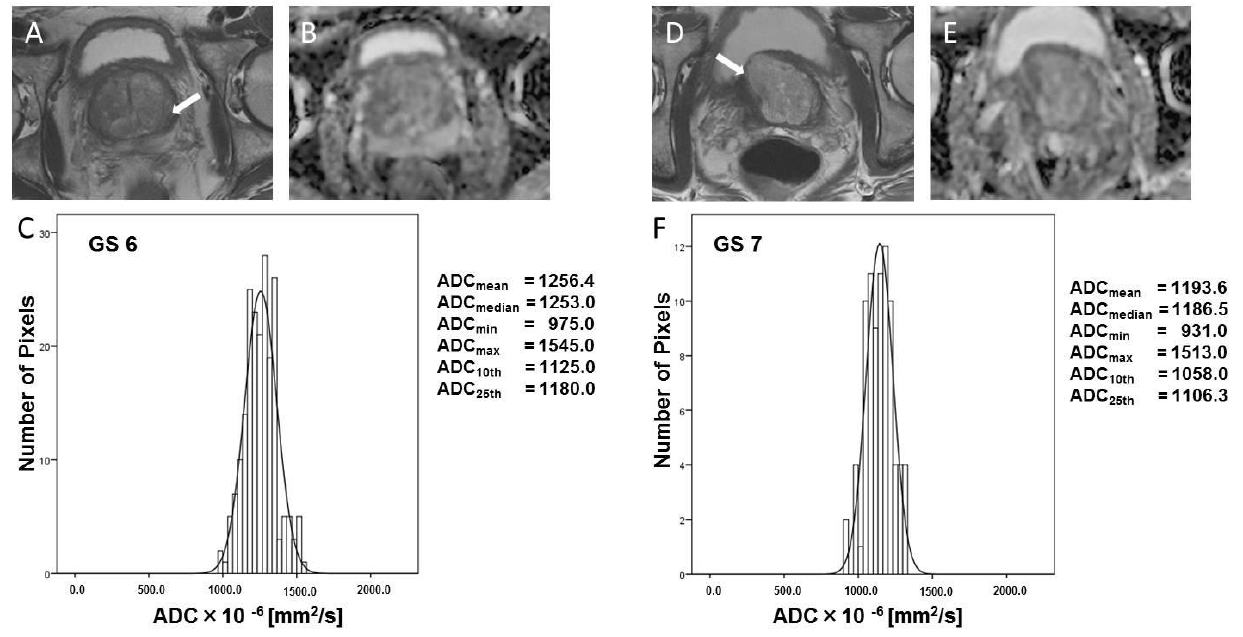
Figure 3. Typical histogram of tumor focus, and T 2 W and ADC images (GS 6 and GS 7). GS = Gleason score. Typical T 2 W images ( A , D ), ADC images ( B , E ), and ADC-derived histograms ( C , F ) for GS 6 and GS 7 prostate cancers. These T 2 W images of prostate cancer illustrate the low signal intensity. The ADC values of the GS 6 lesion reflect slightly restricted diffusion on the ADC map (( B ), ADC mean = 1256.4 × 10 −6 mm 2 /s). The ADC values of the GS 7 lesion are lower than that of the GS 6 lesion on the ADC map (( E ), ADC mean = 1193.6 × 10 −6 mm 2 /s). White arrows indicated tumor foci.